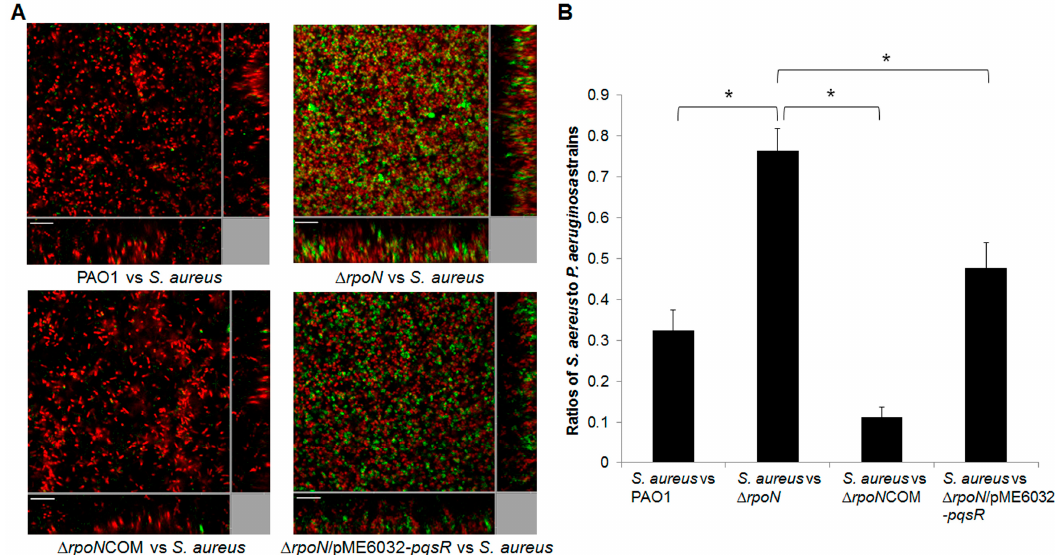
Figure 3. ( A ) Images of biofilm co-cultures of S. aureus 15981/pSB2019 with (i) PAO1; (ii) ∆ rpoN ; (iii) ∆ rpoN COM and (iv) ∆ rpoN /pME6032 -pqsR , respectively. S. aureus 15981/pSB2019